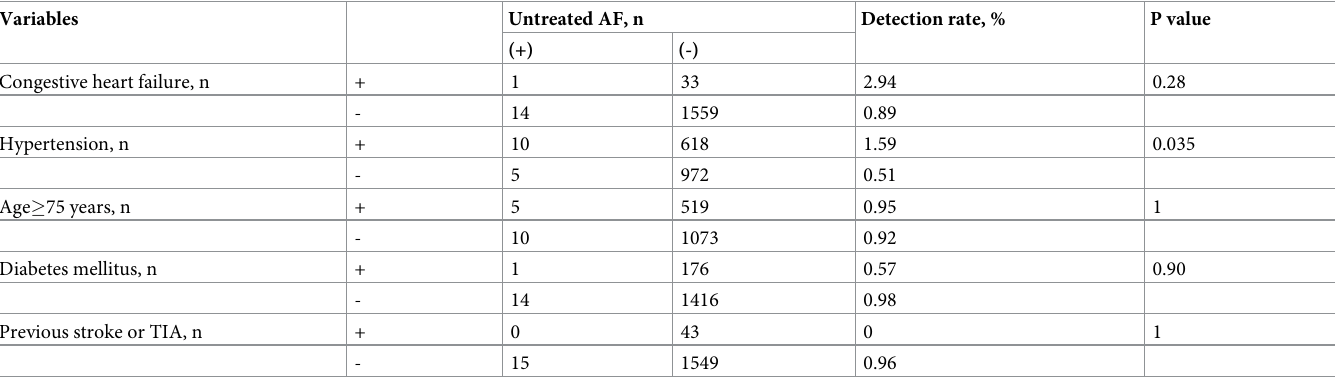
Table 4. Detection rate of untreated AF by each component of CHADS2